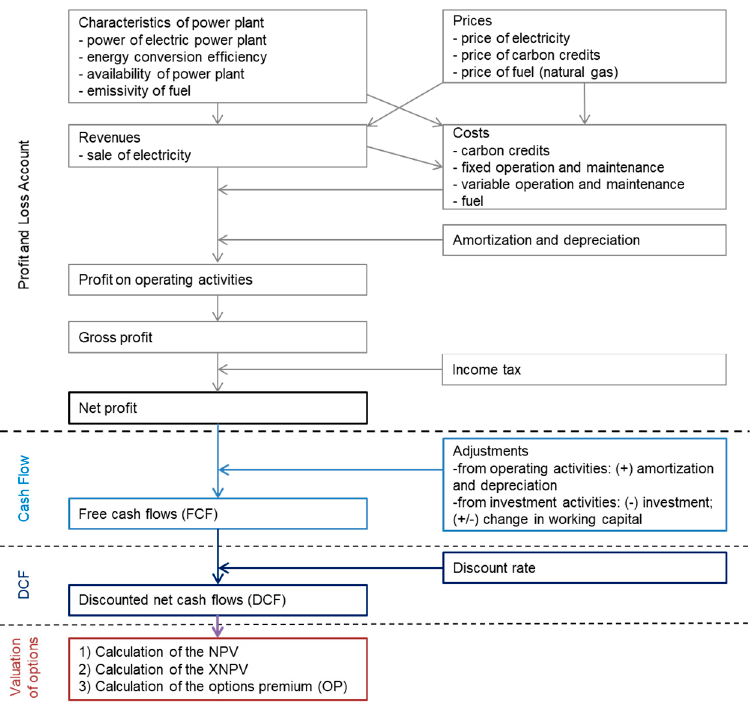
Figure 2. The scheme for estimating cash flows, the net present value (NPV), and the extended net present value (XNPV) in the valuation model.